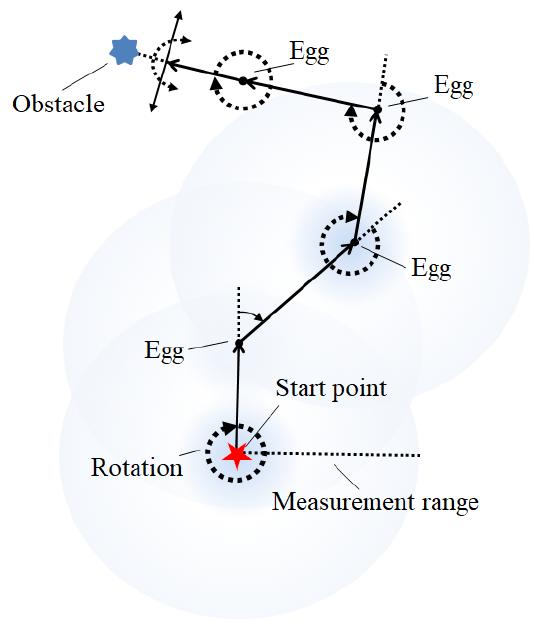
Figure 4. The behavior ‐ based navigation method used for the robot.